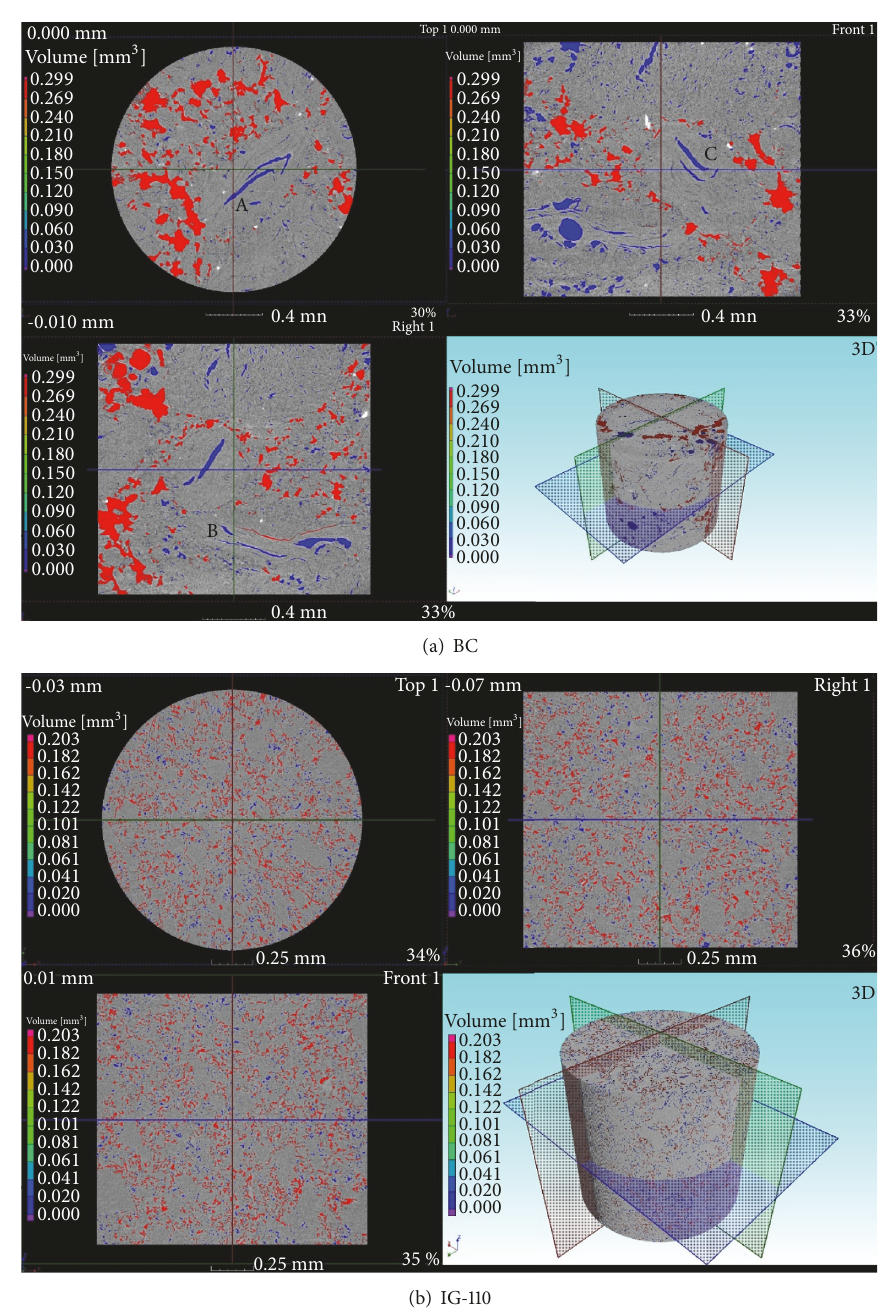
Figure 5: The cross-sectional images of BC and IG-110. The cross-sectional images are taken from the previous, left and upper directions respectively, and the positions of the cross-sectional images are shown in the three-dimensional model of the lower right corner in the